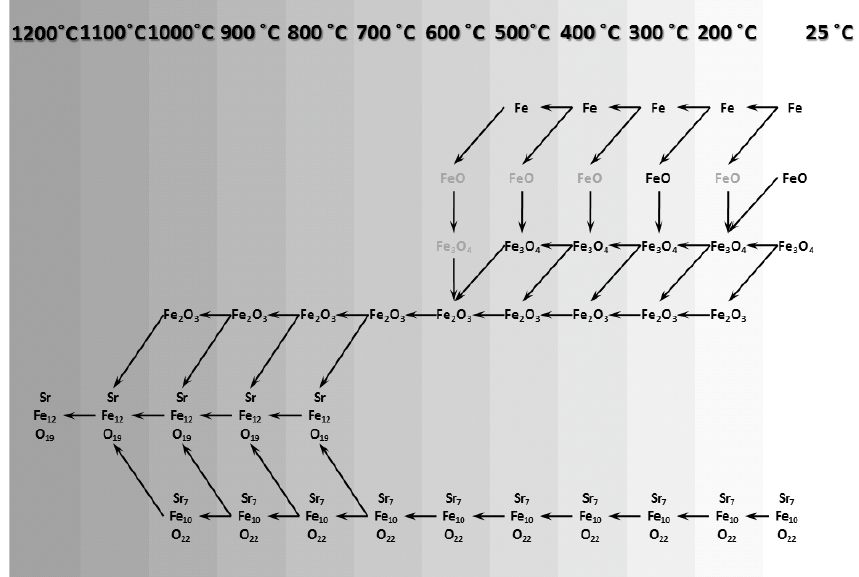
Figure 12. Phase transformation map suggested for the re-calcination of gas heat treated Sr-hexaferrite.